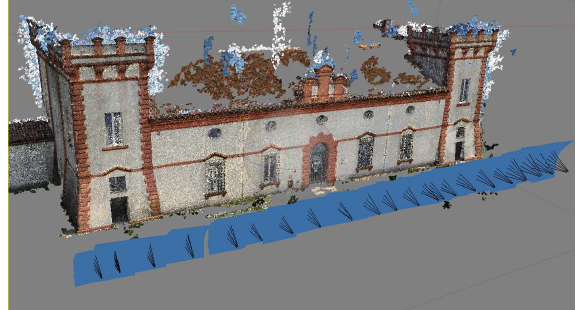
Figure 9. Camera positions for the survey of the front façade.